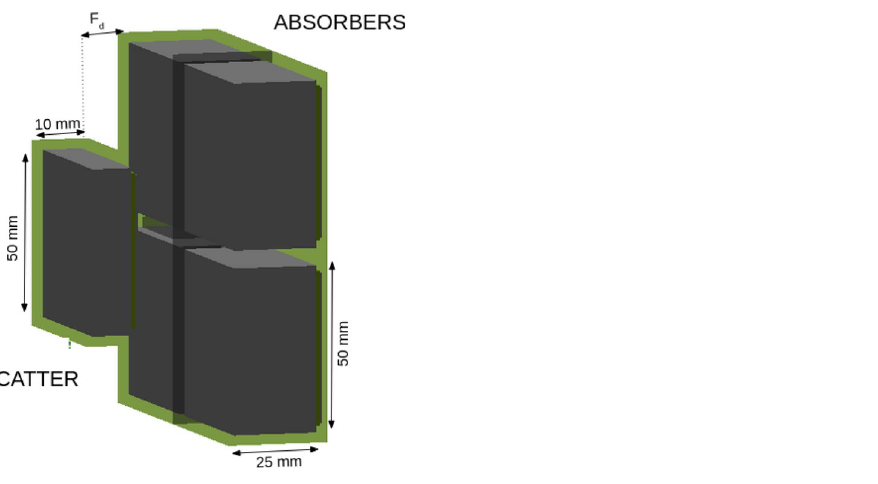
Figure 10. Left: i-TED detector consisting of one scatter and four absorber detectors in movable and parallel detection planes. Right: Schematic view of the same i-TED detector as implemented in GEANT4 indicating the dimensions of the LaCl33(Ce) crystals of the scatter and absorber planes.